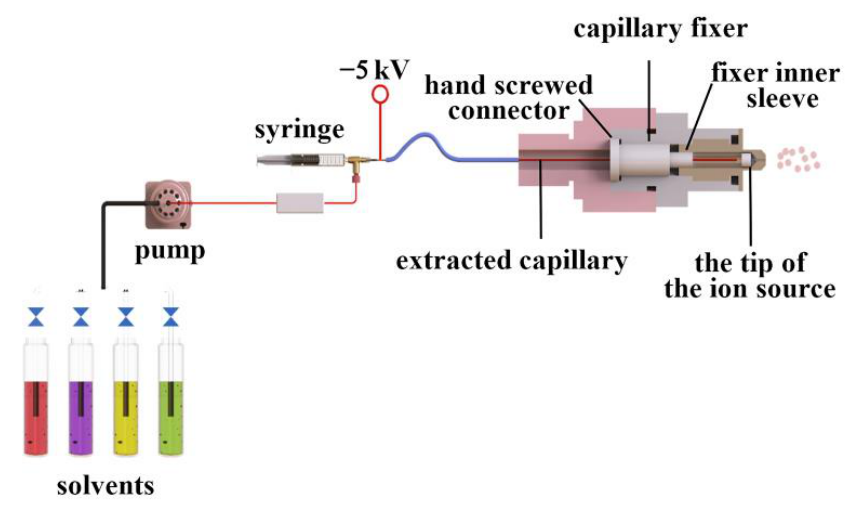
Figure 1. The apparatus diagram of the iEESI-MS.